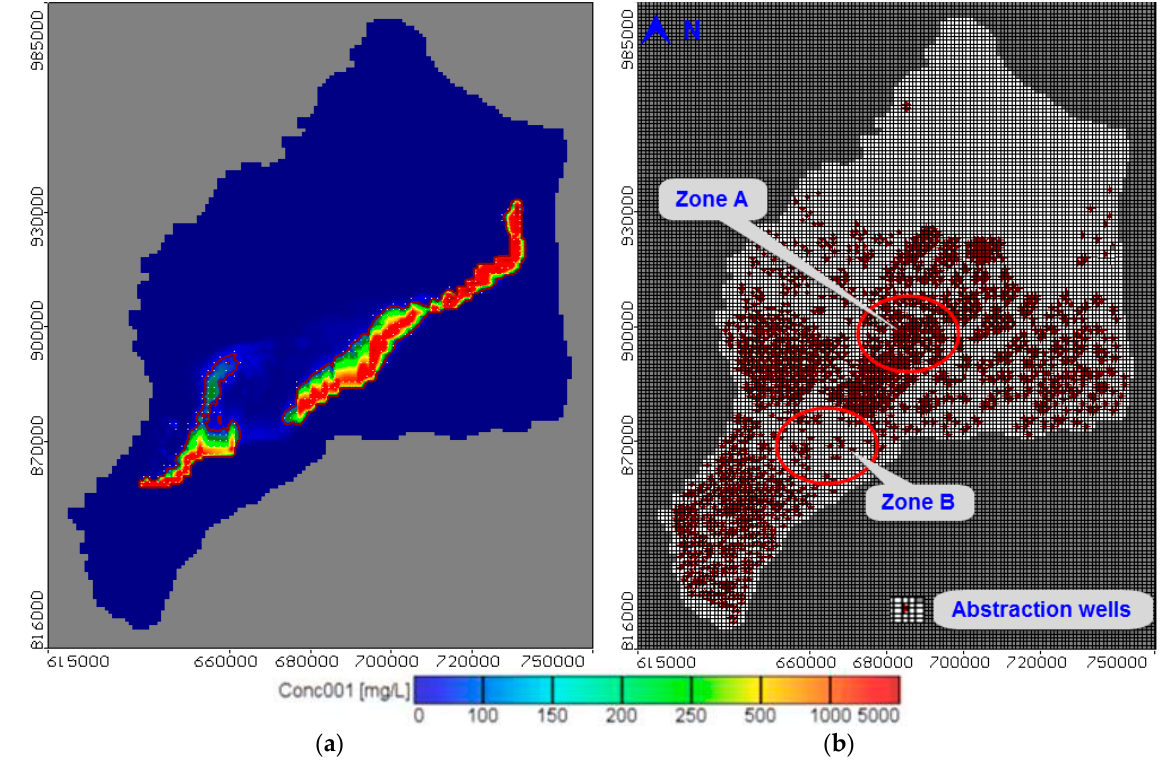
Figure 5. Area view for ( a ) TDS in the ENDA and ( b ) location of the cross-sections with abstraction well distribution.